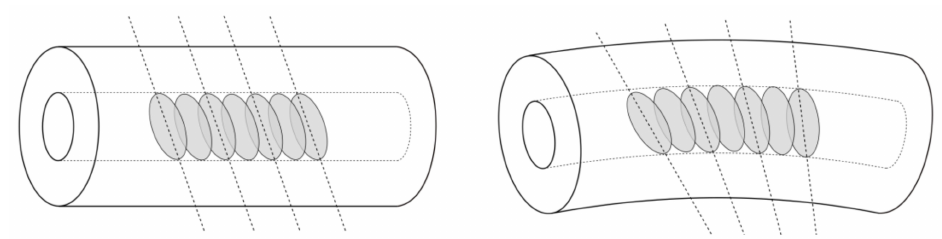
Figure 1. TFBG grating as a sensor for measuring the bending radius of an optical fibre. Changes in the tilt angle of the polarisation planes of the TFBG grating cause changes in the transmission of the lower order modes. This mainly concerns the change of the peak amplitude. More complex systems of TFBG gratings have the possibility of determining the two-dimensional curvature [15]. Since the tilt of the refractive index changes introduces the asymmetry of the fibre and the appearance of orthogonal modes, this property can also be used for directional bend sensing